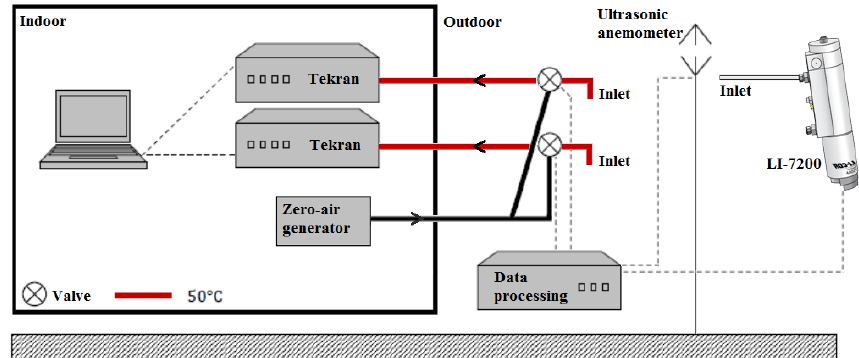
Figure 5. A schematic representation of the GEM REA